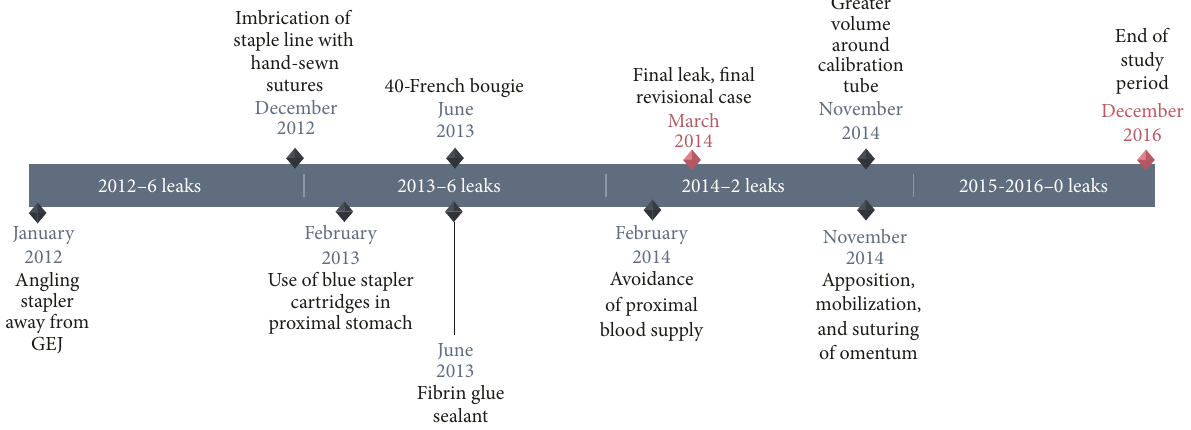
Figure 6: Timeline of technique